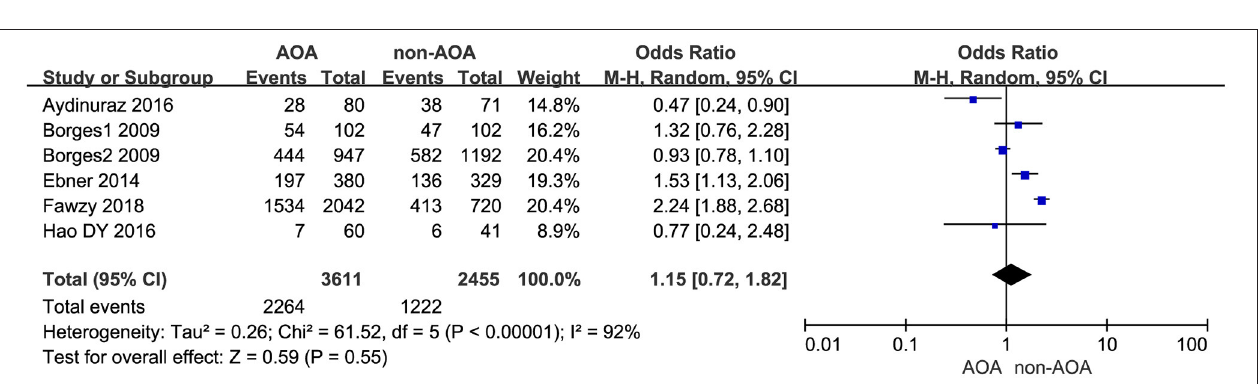
FIGURE 6 | Forest plot of top-quality embryo rate between AOA treatment and non-AOA treatment patient groups using calcium